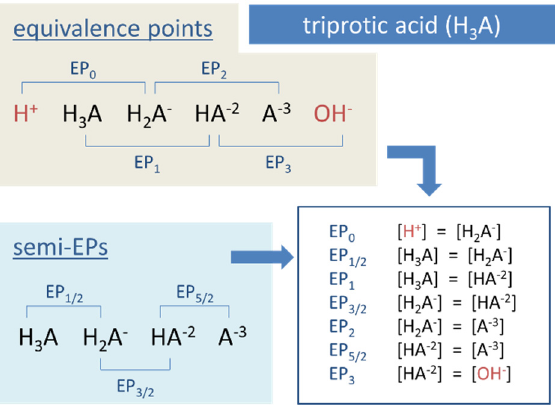
Figure 12. Equivalence points of a triprotic acid—the common approach.